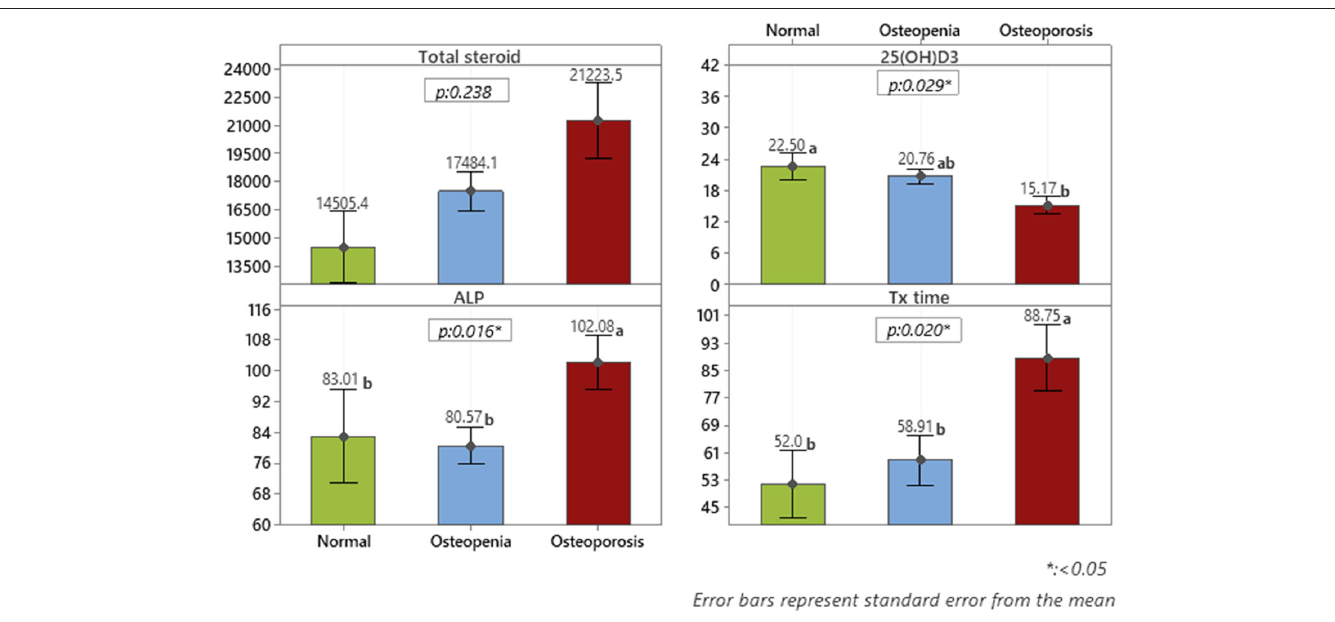
Figure 2. Interval plot of total steroid, Tx time, ALP, and 25(OH)D3 for patients in the study groups. 25-OHD3, 25-hydroxy vitamin D3; ALP, alkaline